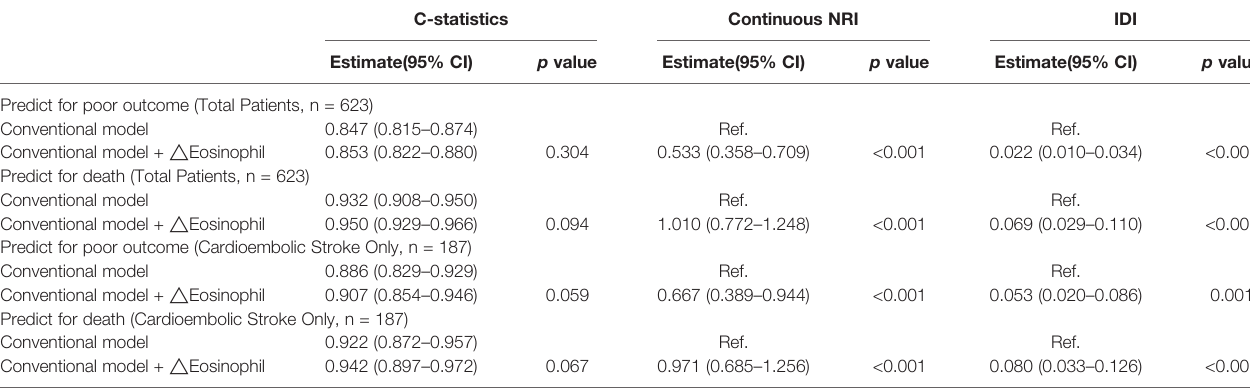
TABLE 4 | Reclassi fi cation and discrimination statistics for adverse outcomes by eosinophils changes after intravenous thrombolysis in AIS patients. C-statistics Continuous NRI IDI Estimate(95% CI) p value Estimate(95% CI) p value Estimate(95%